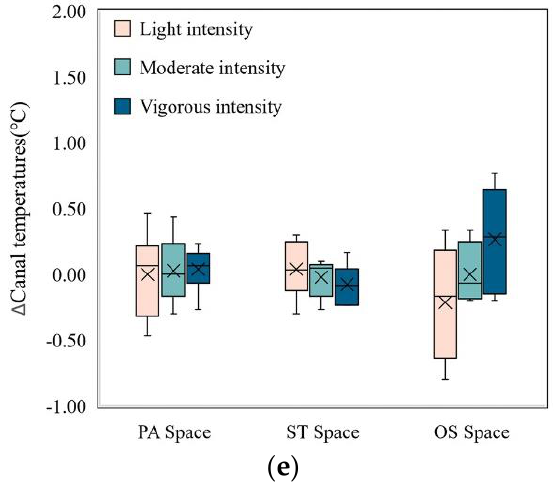
Figure 8. Box plots of ∆SBP, ∆DBP, and ∆HR among spaces (∆SBP ( a ), ∆DBP ( b ), ∆HR ( c ), ∆ SpO2 ( d ), and ∆ Ear canal temperatures ( e )).